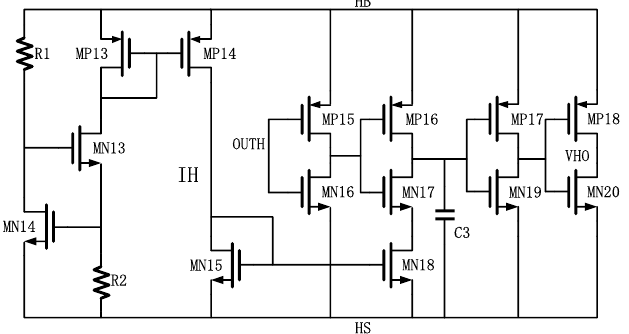
Figure 7. High-side Delay Circuit.